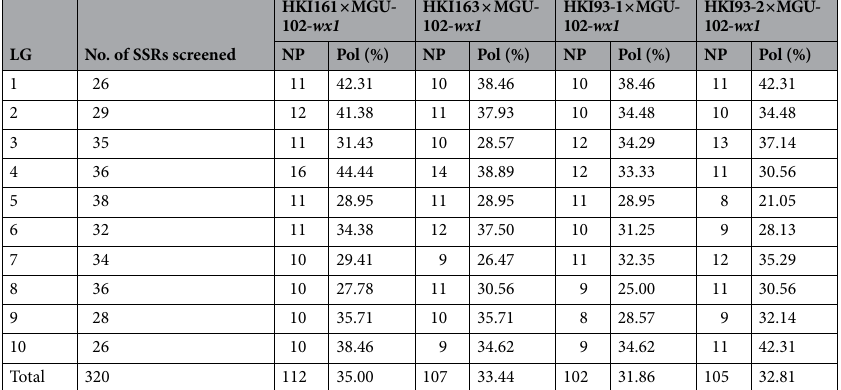
Table 1. Percent polymorphism and distribution of SSRs used in background selection. LG Linkage group, NP No. of observed polymorphic markers, Pol. (%), Polymorphism percentage, SSR Simple Sequence